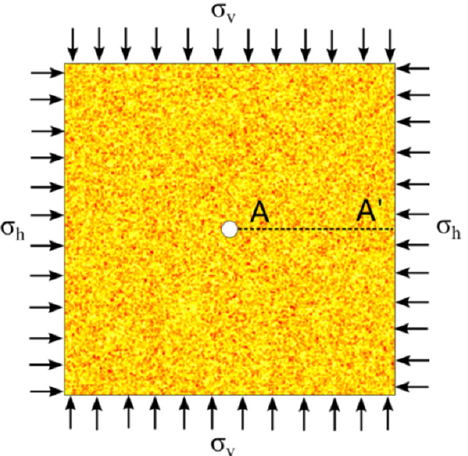
stress is σ h , and the vertical stress is σ v . The dashed line A-A (cid:48) in Figure 3 extends from the right side of the central circular hole to the right boundary of the stress field. In addition, the tangential (vertical) and radial (horizontal) stress data of the elements on the dashed line are extracted from the numerically calculated result and from the analytical solution for further comparison.